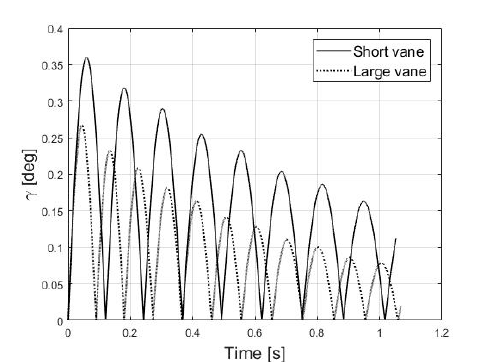
Figure 5. Time evolution of γ for the short and large vanes with V 0 = 56 ms − 1